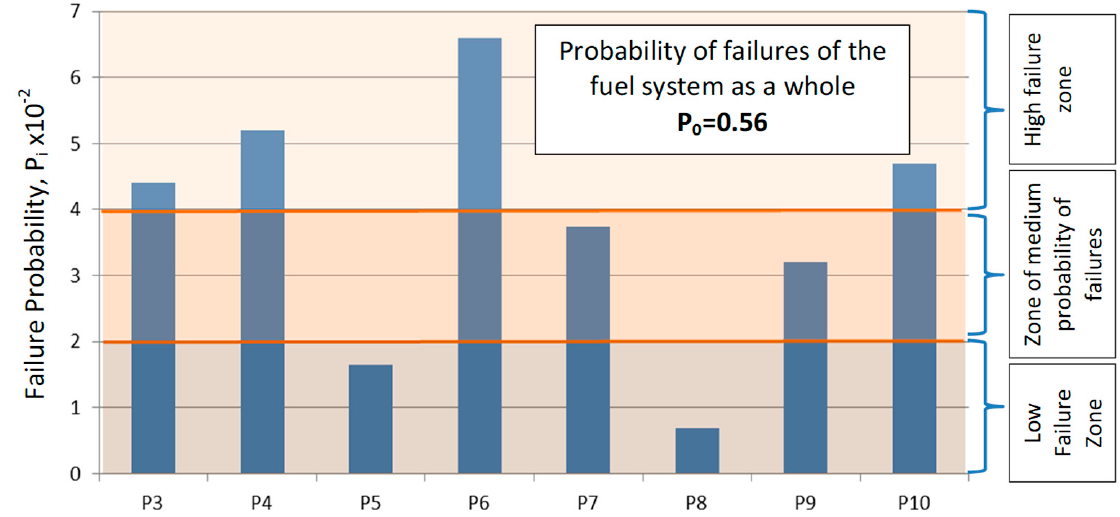
Figure 2. Diagram of failure probabilities of engine fuel system elements without the replacement of structural materials: P 3 —fuel tank failure probability; P 4 —the probability of a booster pump failure; P 5 —probability of filter failure; P 6 —the probability of failure of the high-pressure fuel pump; P 7 —probability of injector failure; P 8 —the probability of pipeline failure; P 9 —the probability of valve failure; P 10 —probability of seal failure.